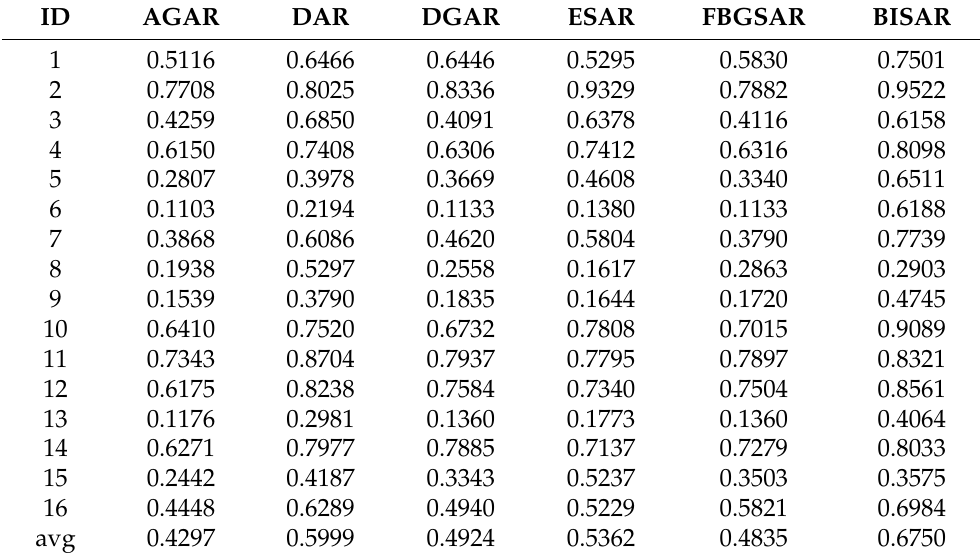
Table 2. The stabilities of reducts (raw data).